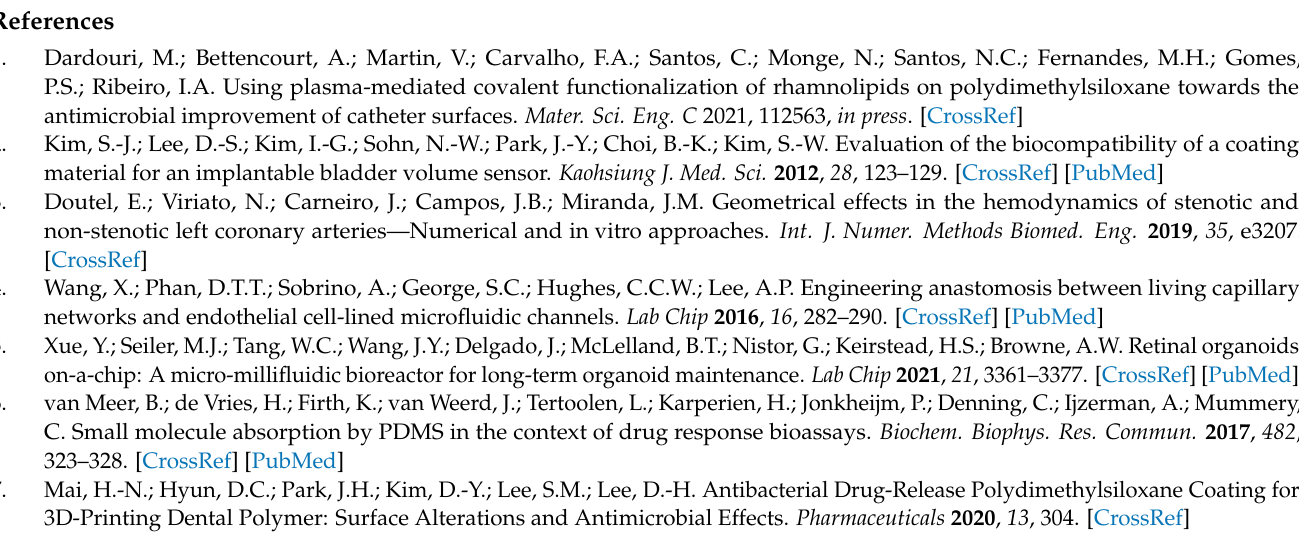
F-d measurements for various stages of hydrophobic recovery. Table S1: Assignment of the FTIR peaks in Figure 3. Figure S2: Sequence of AFM scans of the topography of PDMS embedded with beads, unexposed, immediately after UV exposure, and at various stages of hydrophobic recovery. Figure S3: (a) AFM lateral force scans of PDMS surfaces with embedded hydrophilic beads, (b,c) friction forces on the beads and surrounding area in A and B section (d) ratio of friction forces to the area of beads and their